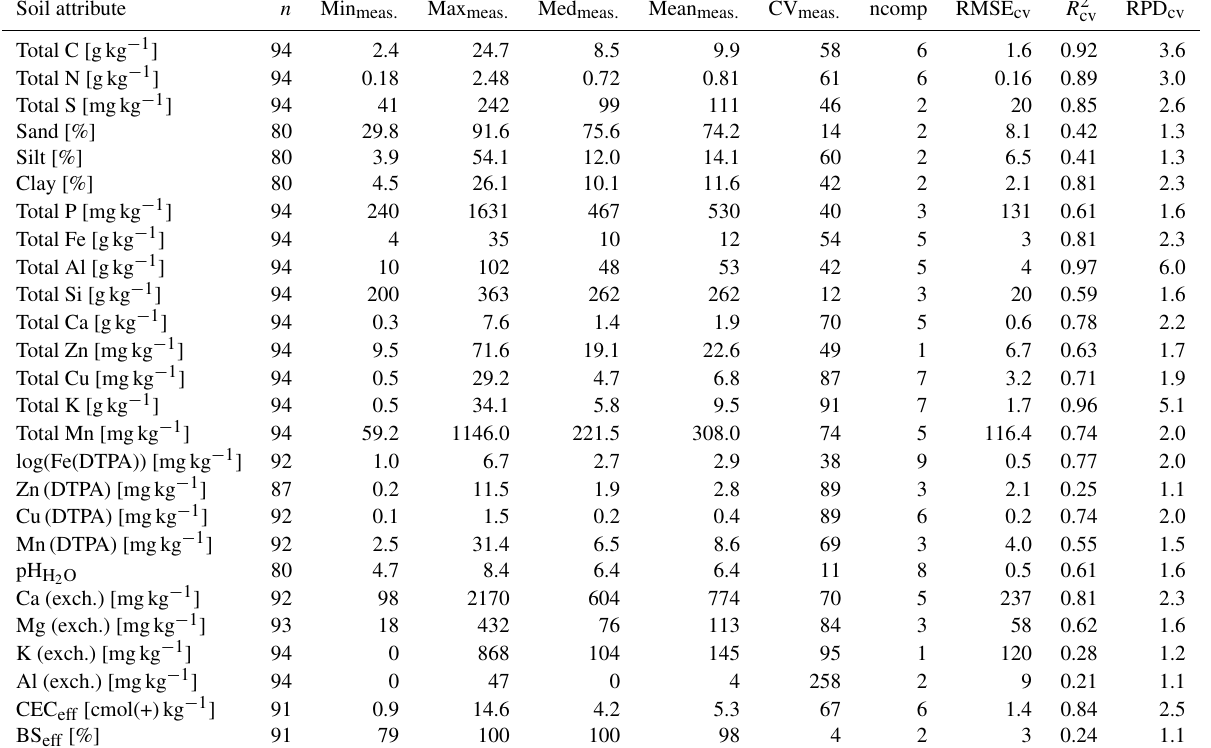
Table 1. Descriptive summary of measured (meas.) soil reference data (see Fig. 1) and evaluation results of cross-validated PLSR models. All samples across the four landscapes were aggregated into a single model per respective soil property. Model evaluation was done on held-out predictions of 10-fold cross-validation (cv) repeated five times at the finally selected number of PLSR components (ncomp). CV is the coefficient of variation, RMSE is the root mean square error, and RPD is the ratio of performance to deviation. C is carbon, N is nitrogen, P is phosphorus, Fe is iron, Al is aluminum, Si is silicon, Ca is calcium, Zn is zinc, Cu is copper, K is potassium, and Mn is manganese. Bioavailable micronutrients were measured by diethylenetriaminepentaacetic acid (DTPA) extraction. Ca(exch.), Mg(exch.), K(exch.), and Al(exch.) signify exchangeable elements determined with BaCl 2 extraction. CEC eff is the effective cation exchange capacity, and BS eff is the effective base